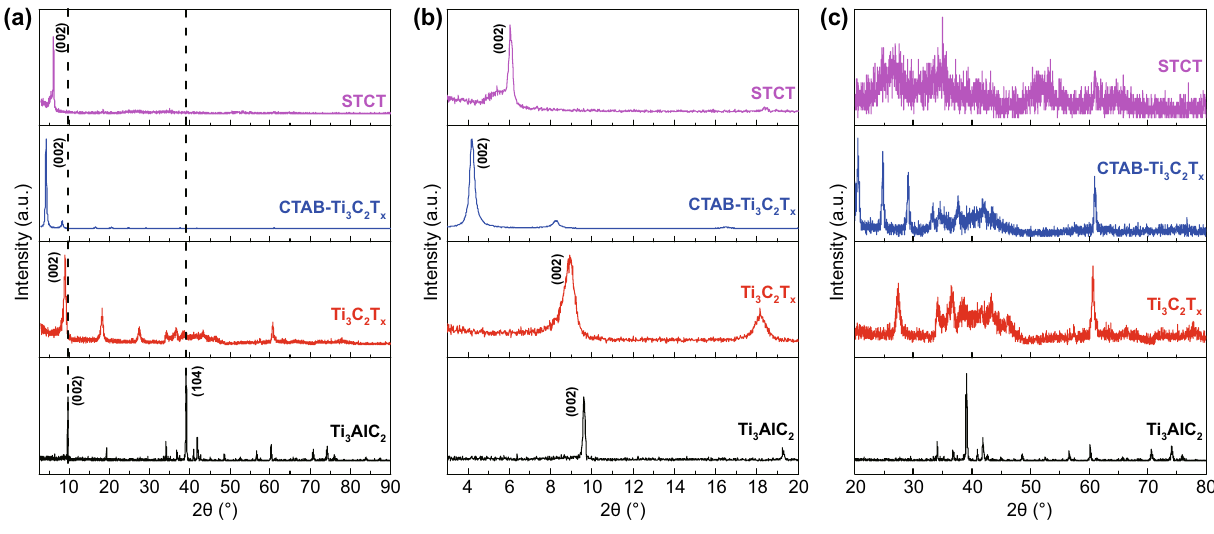
Fig. 2 XRD patterns of Ti 3 AlC 2 , Ti 3 C 2 T x , CTAB‑Ti 3 C 2 T x , and STCT composites at different diffraction angle ranges: a 2 theta from 3° to 90°, b 2 theta from 3° to 20°, and c 2 theta from 20° to